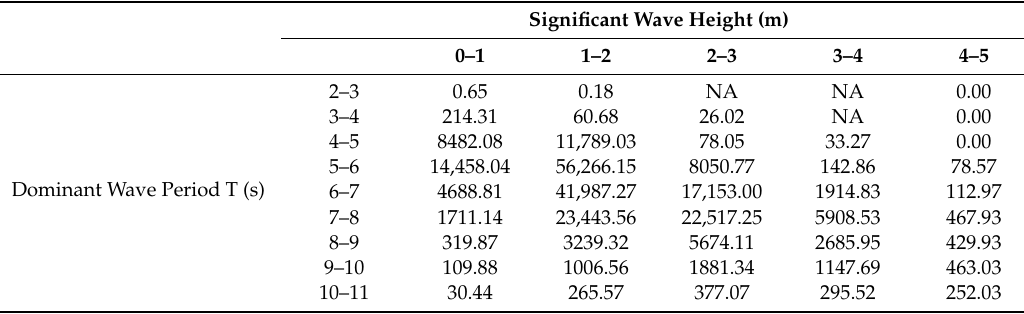
Table 5. Annual energy capture of the self-adjusted wave energy converter.